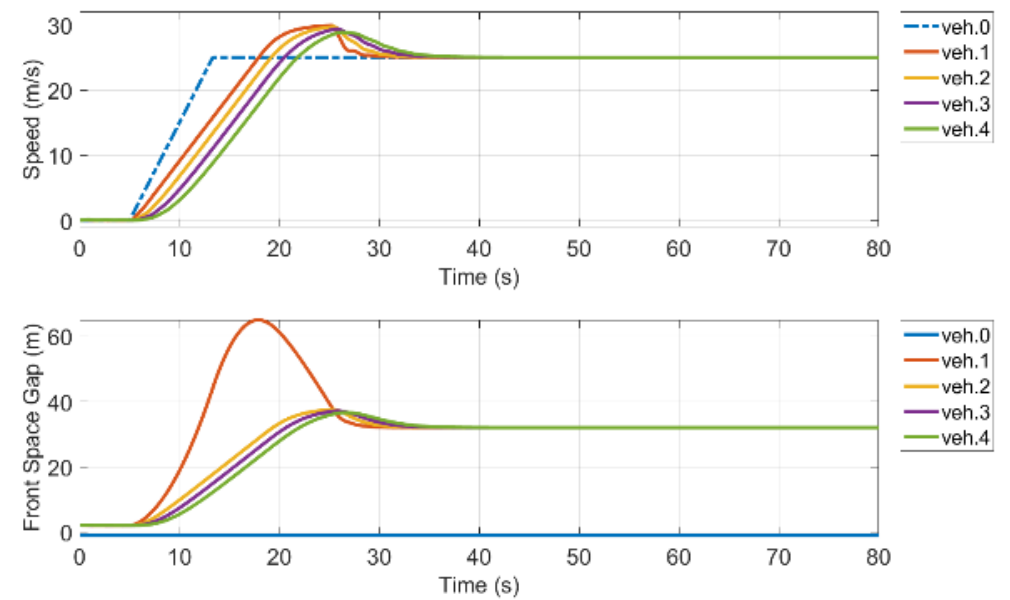
Figure 13. Simulation results of speed (upper) and inter-vehicle distance (lower).